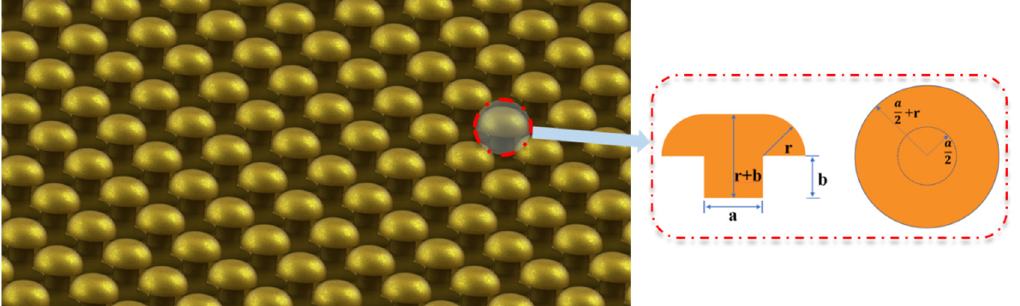
Figure 8. Pushpin-like reinforce microstructure array.